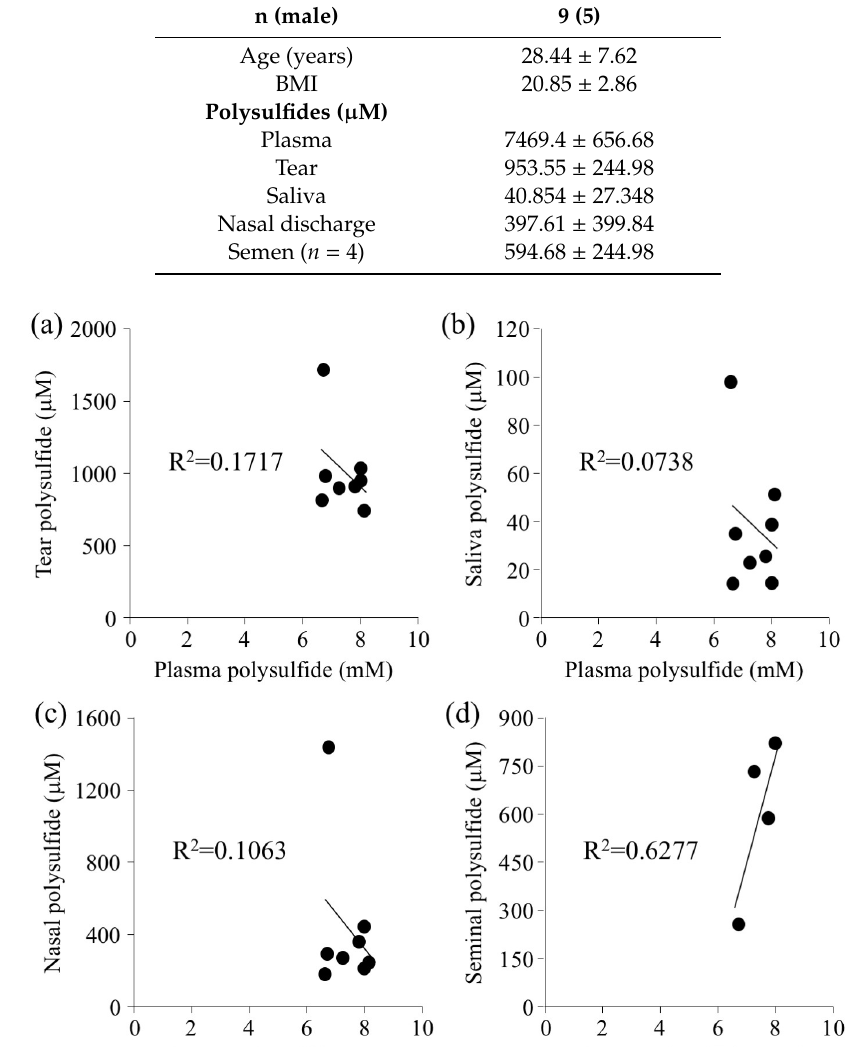
Table 1. Characteristics of healthy human volunteers for analysis according to age, BMI, sex, and results of polysulfide levels.